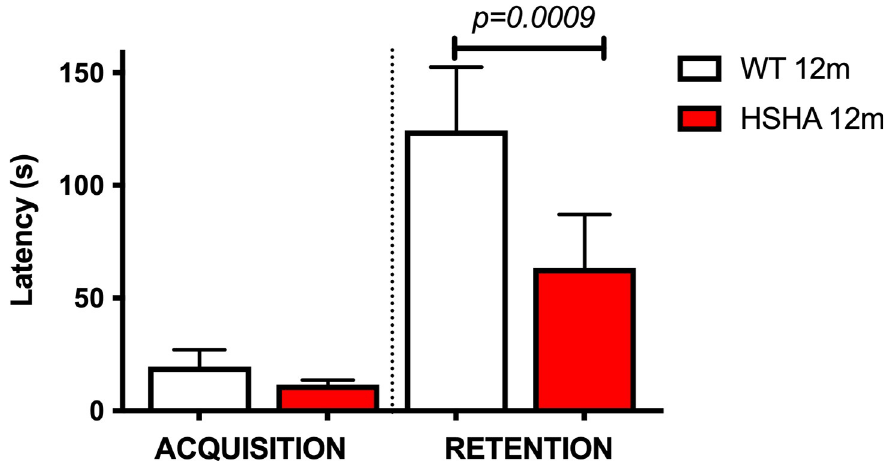
Fig 7. Hippocampal learning behaviour in 12-month-old HSHA mice and their age-matched controls determine by passive avoidance testing. Average latency time in seconds for each group of mice was measured. Statistical significance was assessed by nonparametric Krusal–Wallis test, followed by Dunn AU : PleasenotethatasperPLOSstyle ; eponymictermsshouldnotbepossessive : Hence ; allinstancesofDunnsmultiplecomparisonstesthavebeenreplacedwithDunnmultiplecomparisonstestthroughoutthetext : Pleasecheckandcorrectifnecessary : multiple comparisons test. Data are presented as mean ± SEM; n = 6 for WT and n = 15 for HSHA; p -values only indicated for significance. The data underlying Fig 7 can be found in S1 Data. HSHA, hepatocyte-specific human amyloid; WT, wild-type.